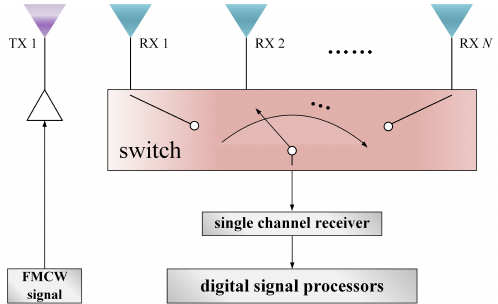
Figure 1. Block diagram of switch antenna array (SAA) frequency modulated continuous wave (FMCW) radar.